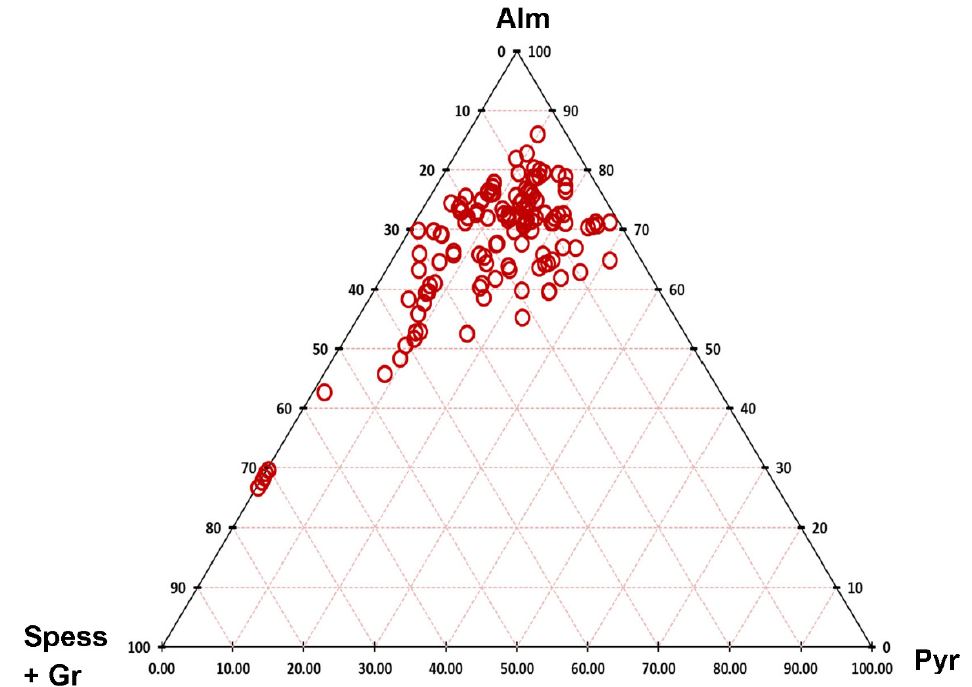
Figure 10. Ternary Alm-Pyr-(Spess+Gr) plot showing the range in garnet compositions from the northern Brahmaputra River sands.